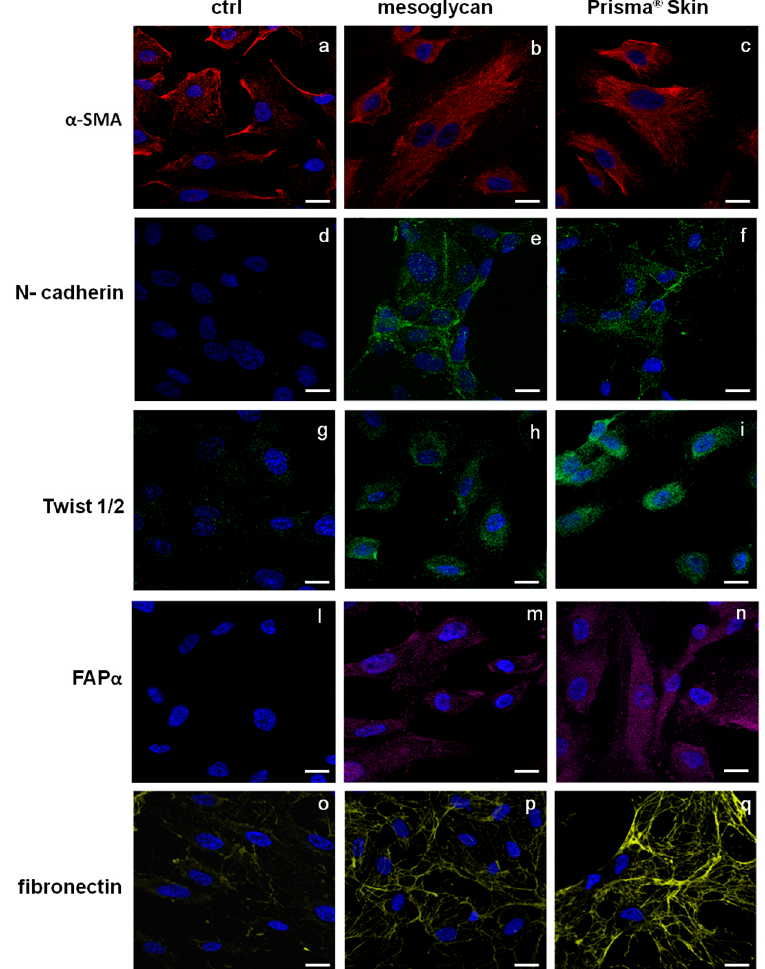
Figure 5. Immunofluorescence analysis to detect: α -SMA ( a–c ); N-cadherin ( d – f ), Twist 1/2 ( g–i ); FAP α ( l – n ); and fibronectin ( o – q ) treated with mesoglycan and Prisma ® Skin for 48 h. Nuclei were stained with DAPI. Magnification 63 × 1.4 NA. Bar = 10 µ m. All the results are representative of three experiments with similar results.